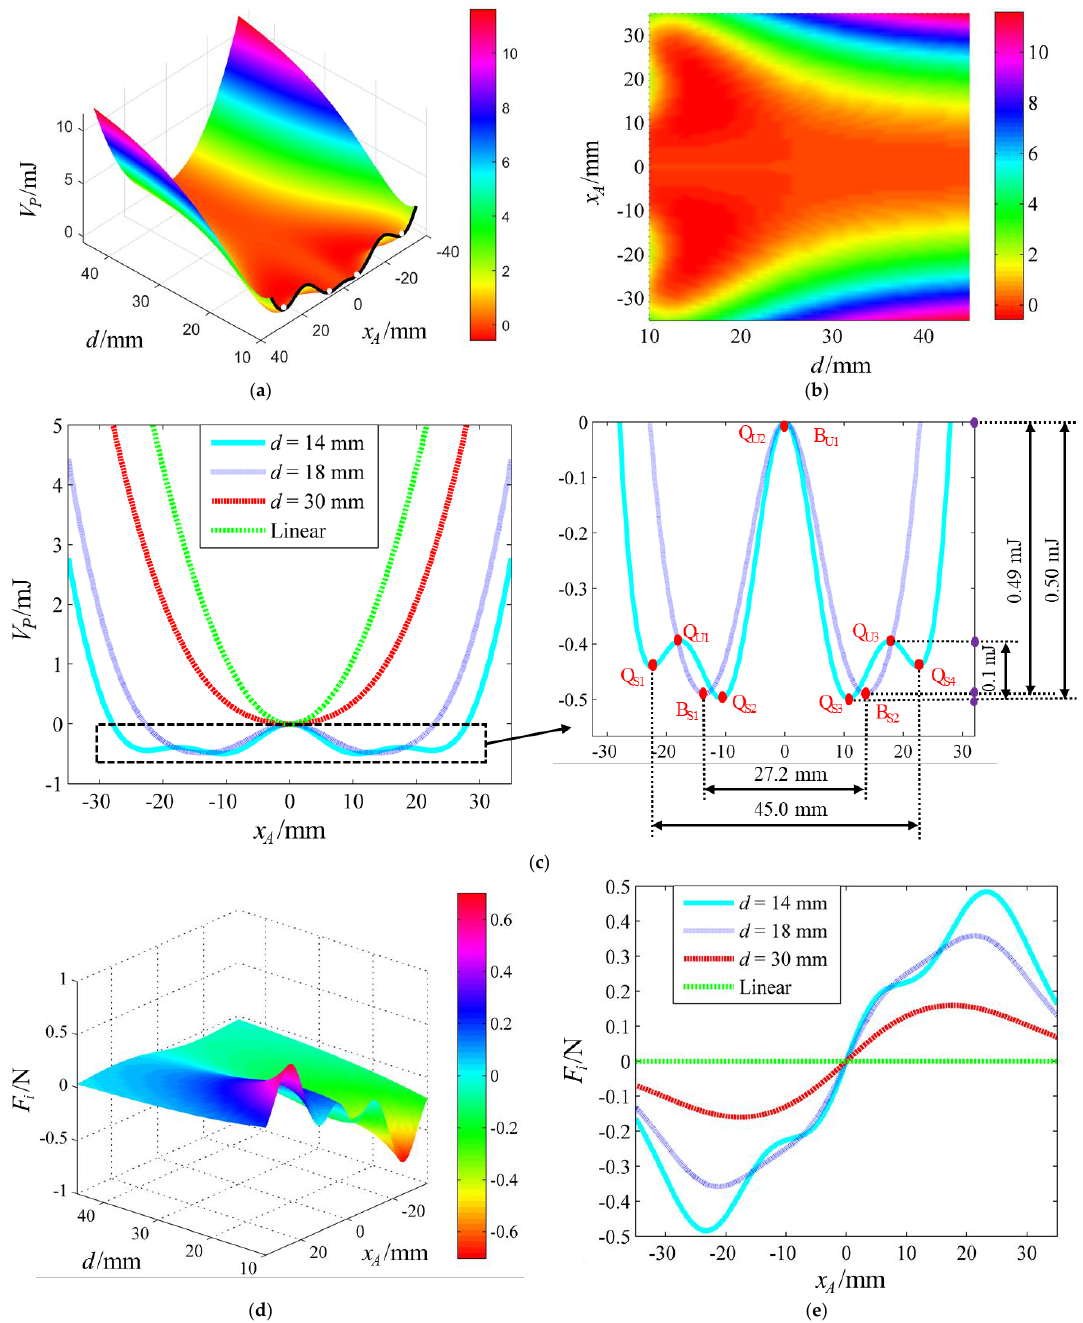
Figure 2. ( a ) The potential energy V p varying with the vertical displacement x A and magnet spacing d ; ( b ) the projection of V p in the x A – d plane; ( c ) V p – x A curves when d = 14, 18, and 30 mm, and the harvester is in the linear state; ( d ) the vertical magnetic force F i varying with x A and d ; ( e ) F i – x A curves when d = 14, 18, and 30 mm, and the harvester is in the linear